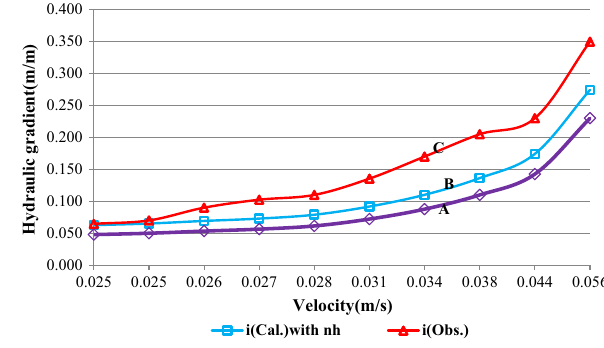
Fig. 7 Comparing plots of hydraulic gradient versus velocity for CGM1 series. Results are start of run. Curve “A” shows variations of ( i ) versus ( V ) based on common porosity concept, curve “B” shows variations of ( i ) versus ( V ) based on hydraulic porosity